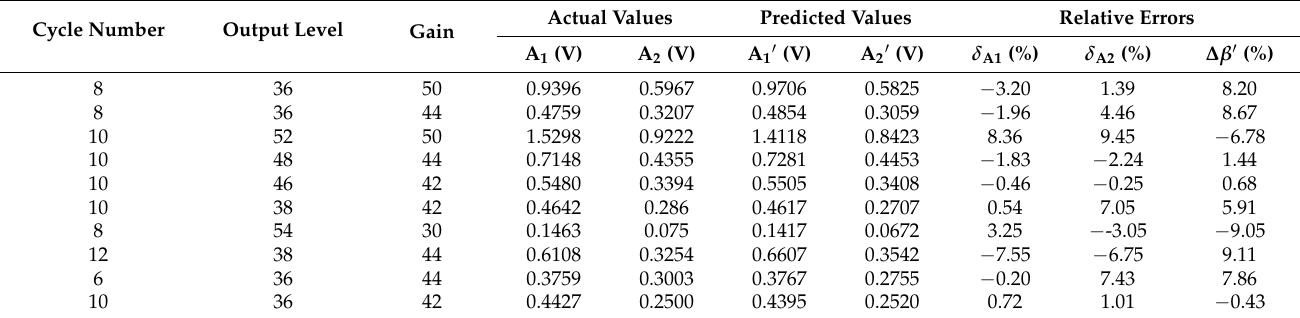
Table 5. Comparison of the predicted values with the RSM and the experimental values. Cycle Number Output Level